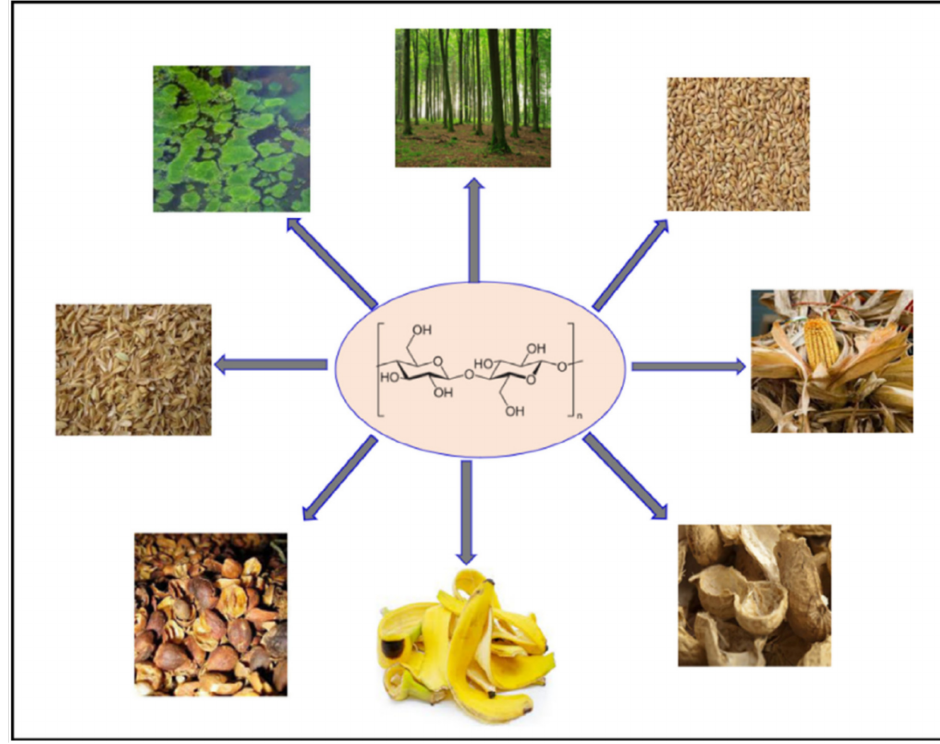
Figure 2. Selective sources of cellulose extraction [69]. Copyrights: Elsevier, 2022.